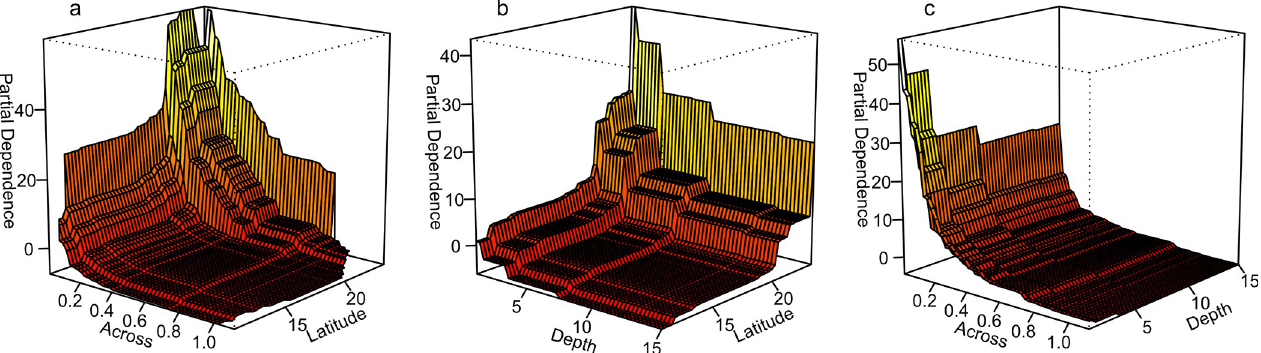
Fig 3. Total macroalgal cover (MA) as a function of the three strongest spatial variables. Partial dependence plots, showing changes in MA as deviation from their mean value of 9.3% (vertical axis and colour contours, in percent cover) attributable to the three interacting spatial predictors: relative distance across the continental shelf (0 = coast, 1 = offshore), latitude (˚S), and depth (m) ( a–c ). Relative percentual influence of the predictors to main effects without interaction: across = 40.8%, latitude = 26.4%, depth = 20.0%, within-reef location = 6.71%, reef type =